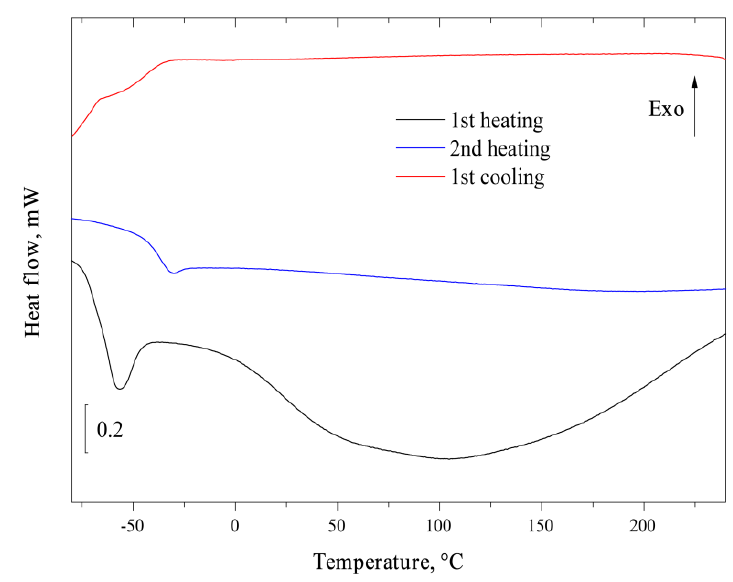
Figure 4. Fast scanning calorimetry curves of AEBA–TEG.